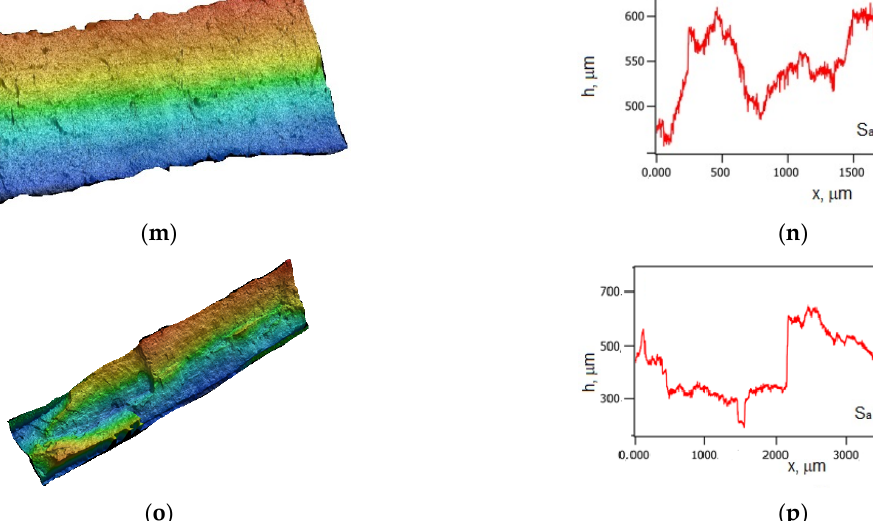
Figure 5. Roughness profiles of Ti-6Al-4V fracture surfaces. Left column shows 3D images of the fracture surface profile; right column shows profiles of height h along a straight-line segment parallel to the OX axis and equidistant from the surfaces of the specimen along a line equidistant from the sample surfaces. Strain rate and notch radius are: 10 3 s − 1 , smooth ( a , b ); 10 3 s − 1 , 10 mm ( c , d ); 10 3 s − 1 , 5 mm ( e , f ); 10 3 s − 1 , 2.5 mm ( g , h ); 100 s − 1 , smooth ( i , j ); 100 s − 1 , 10 mm ( k , l ), 5 mm ( m , n ); 100 s − 1 , 2.5 mm ( o , p ).